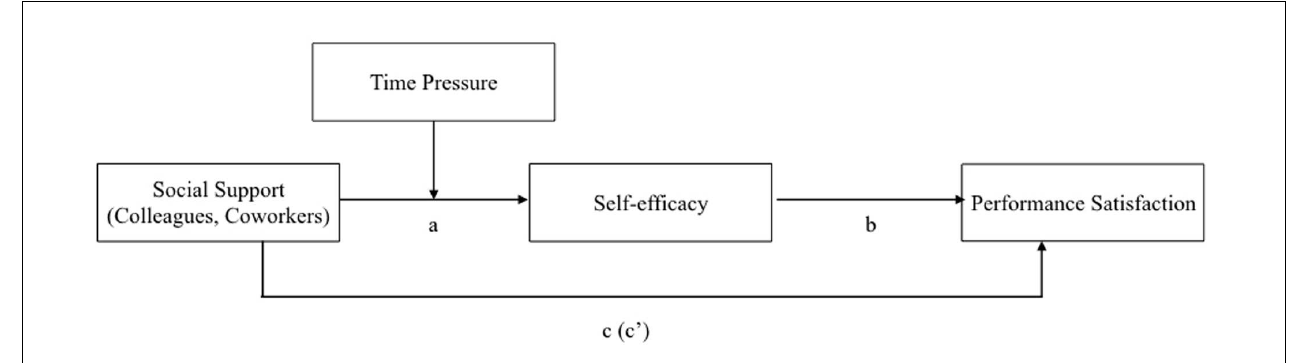
FIGURE 1 | Proposed research